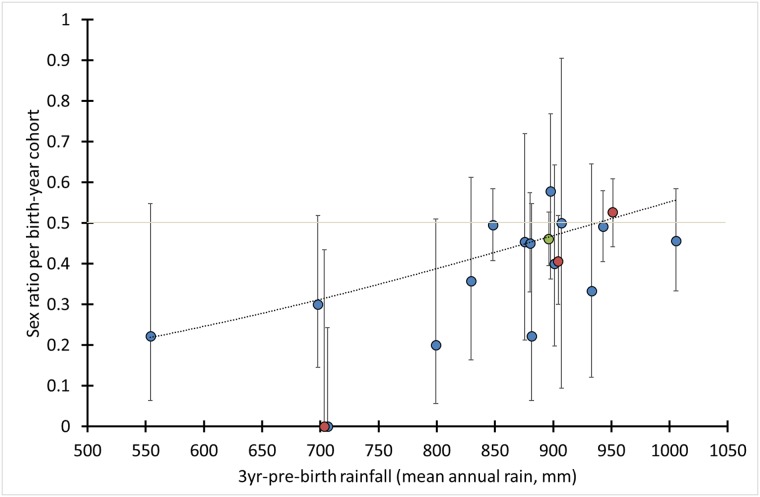
Effect of pre-birth rainfall on sex ratio at birth.Regression line: predicted sex ratio at birth according to logistic regression (P = 0.0026), data points: observed sex ratio per birth-year cohort, blue: individuals ≥ 2 years old, red: 0–1 year old calves (at 951 mm: 74 calves and three 2-year olds), green: 126 1-year old calves and 91 2-3-year olds, error bars: 95% CI (Wilson method). Test 7, Table 2.